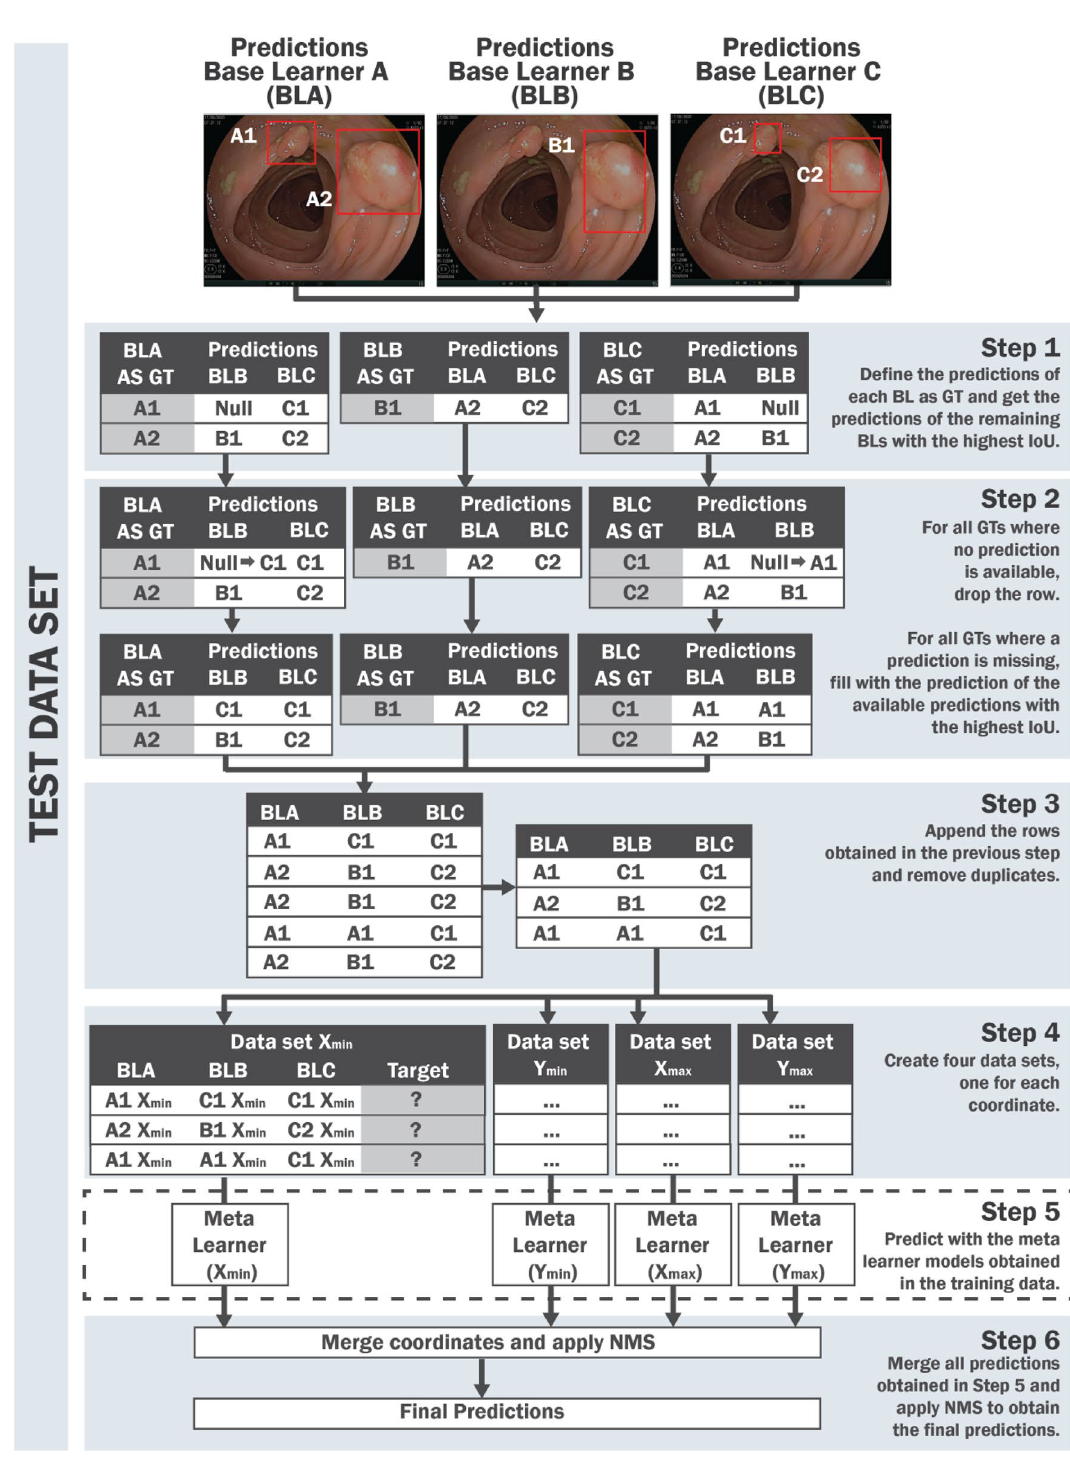
Figure 3. StackBox over the test data. In Step 1, the predictions of each base learner are considered as the ground truth, one at a time, and the predictions returned by the remaining models that have the highest IoU with the ground truth are chosen. In Step 2, similar to the method used in the training data, the ground truths without associated predictions are removed. When the number of predictions is lower than the number of base learner models used minus one, the null values are filled with the prediction where the IoU with the ground truth is higher. In Step 3, all matches obtained in the previous step are concatenated, and the duplicates are removed. In Step 4, four data sets are created according to the coordinates available for each bounding box. The predictors include the corresponding coordinate of each base learner, and the target is predicted using the meta learner models obtained in training data (Step 5). In Step 6, the predictions are combined, and NMS (with a threshold of 0.5) is applied to remove redundant boxes. The red boxes represent the predictions of the base learner models in the test